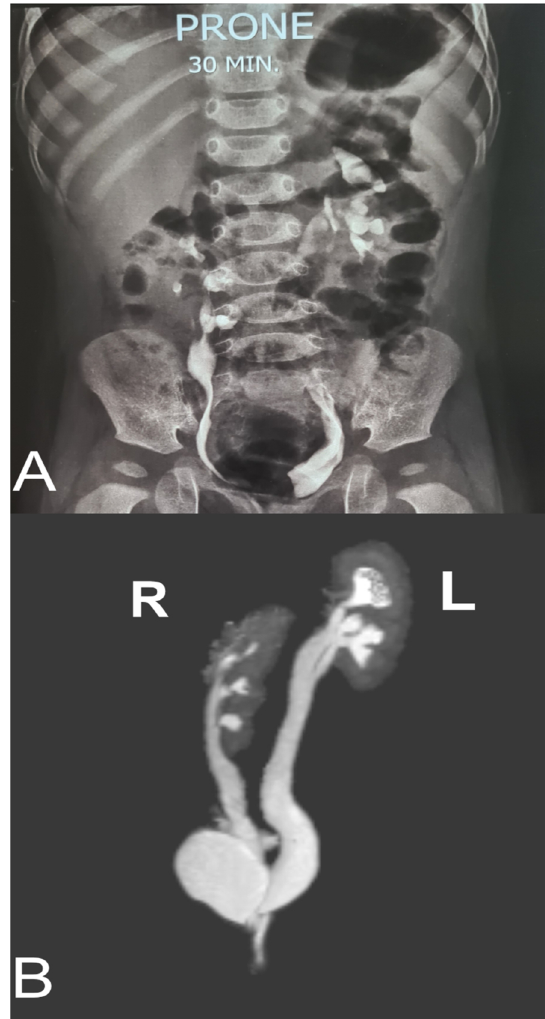
Fig. 5 A IVP image showing bilateral duplex with bilateral ectopic ureters draining outside the bladder.Bladder not opacified even after 30 min. B MRU image showing bilateral incomplete duplication with ectopic insertion of the